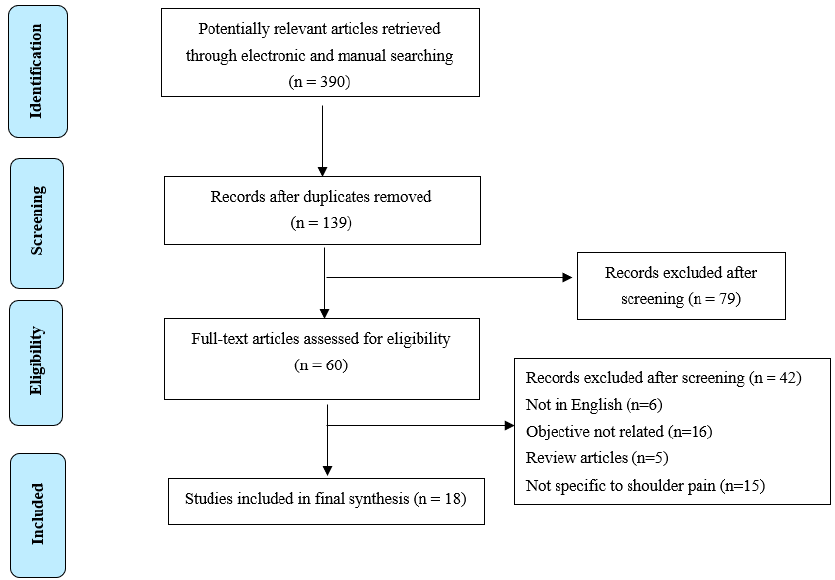
Figure 1. Study selection process and results of the literature search (PRISMA flow diagram).